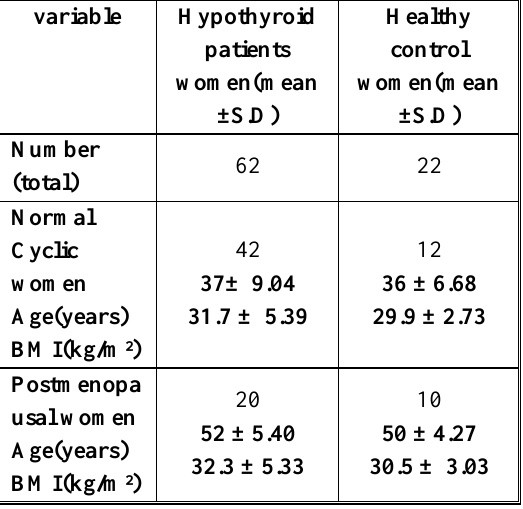
Table 1: Characteristics of control women and hypothyroid patients